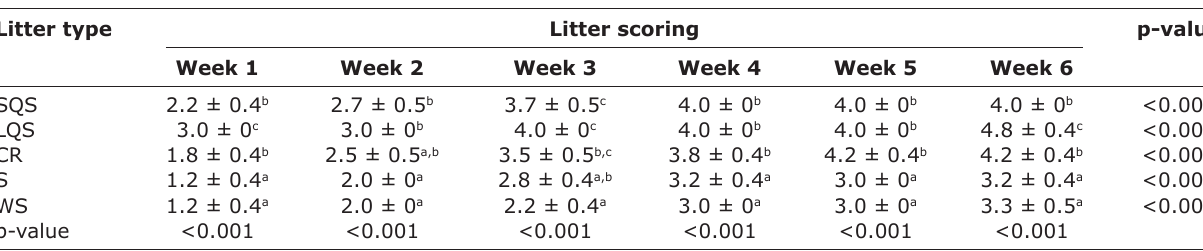
Table-3: Litter quality assessment. Litter